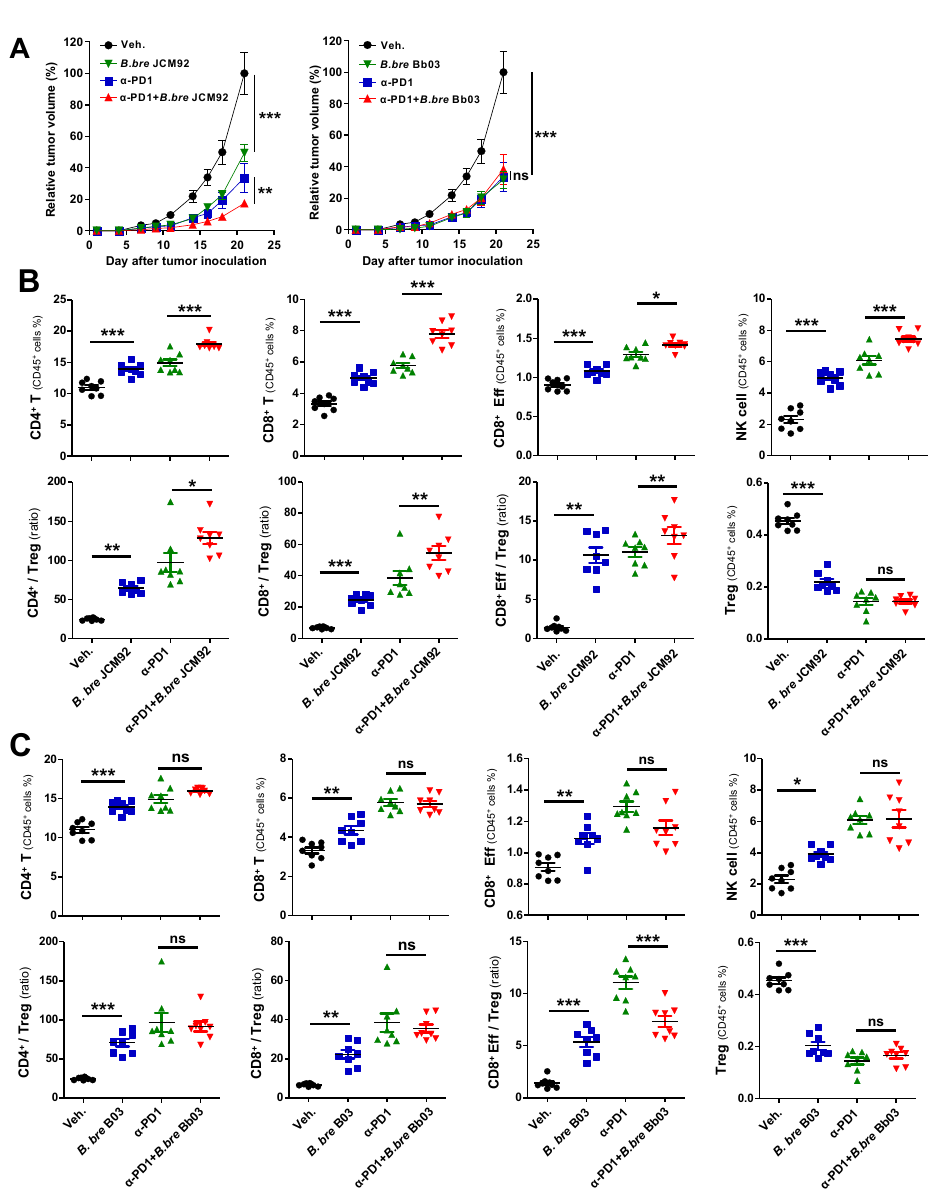
Figure 4. B. bre JCM92 boosted PD-1 blockade efficacy. ( A ) Tumor growth curves after administering B. breve strains, with or without PD-1 blockade. Data are expressed as the means ± SEM. p -values were determined by two-way ANOVA using Tukey’s post-test. ( B , C ) Immune cell profiling of spleen tissue in mice treated with PD-1 blockade in combination with B. bre JCM92 ( B ) or B. bre Bb03 ( C ) using flow cytometry analysis. Data are expressed as the means ± SEM. p -values were determined by one-way ANOVA using Tukey’s post-test. For all graphs, * p < 0.05, ** p < 0.01, *** p < 0.001, and ns, not significant.